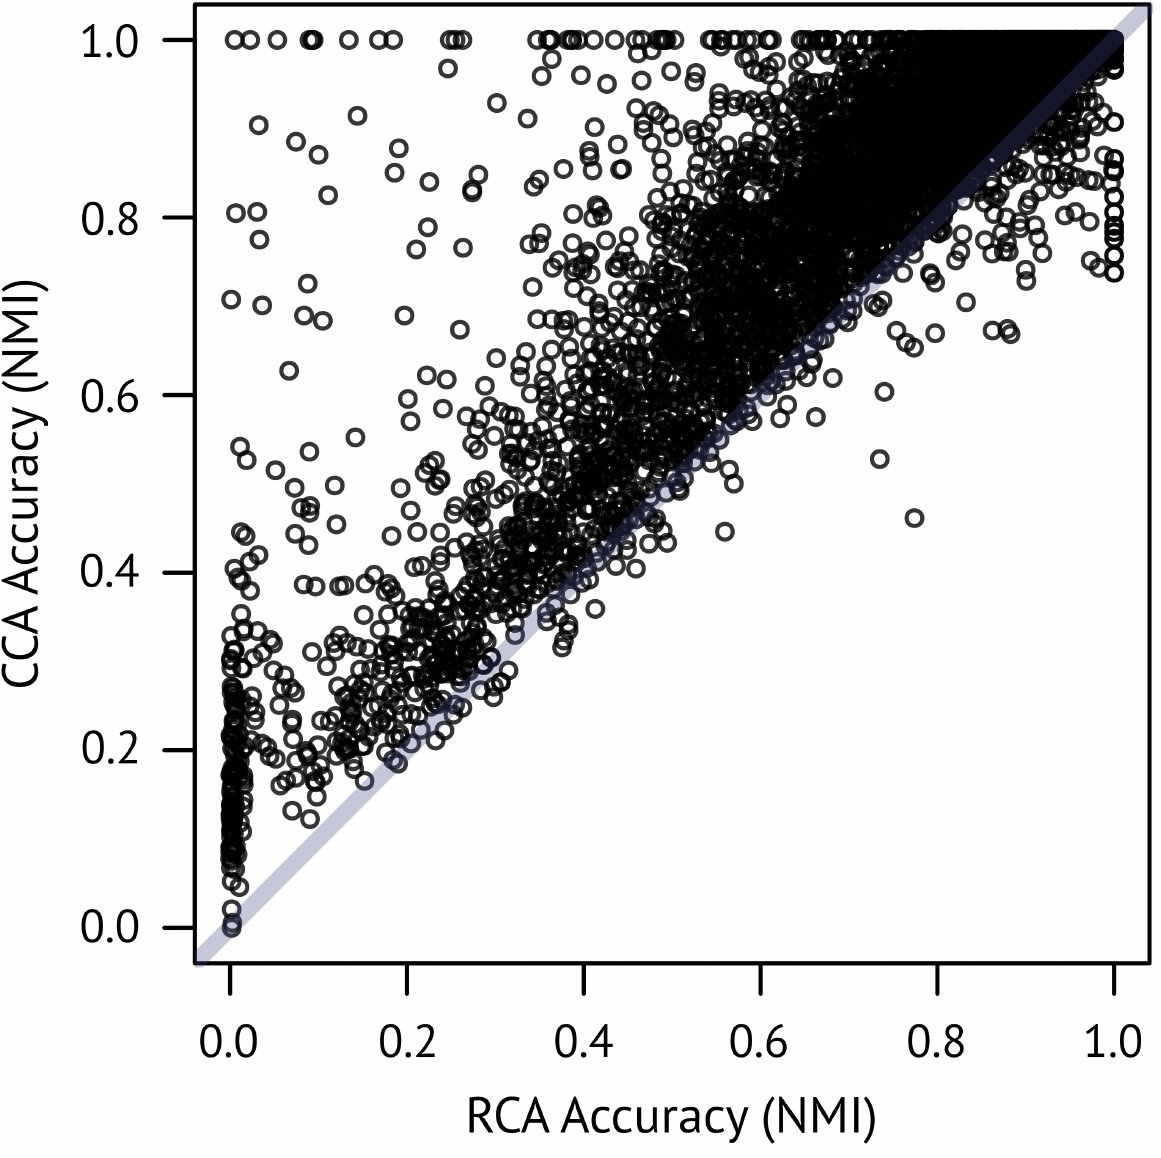
Figure 5: CCA accuracy compared with RCA accuracy for 5,000 simulation runs. Each point is a single run. Runs in which CCA was more accurate are above the Y = X diagonal (in gray), and those in which RCA was more accurate are below. Note the absence of points in the bottom-right